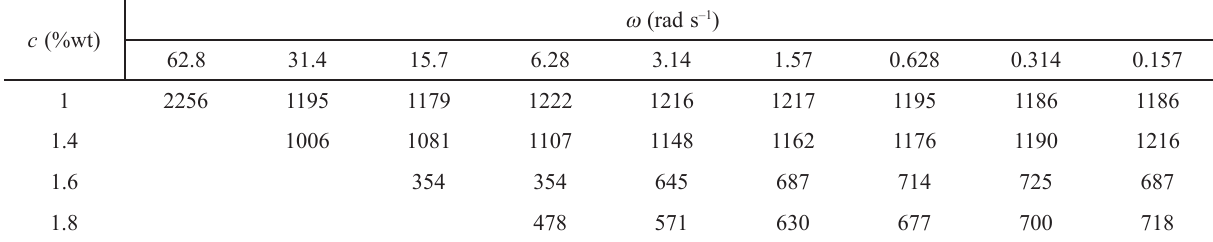
(in seconds) obtained from the time evolution of the viscoelastic moduli at different Table 1 – Values of the crossover times t cr frequencies and concentrations c